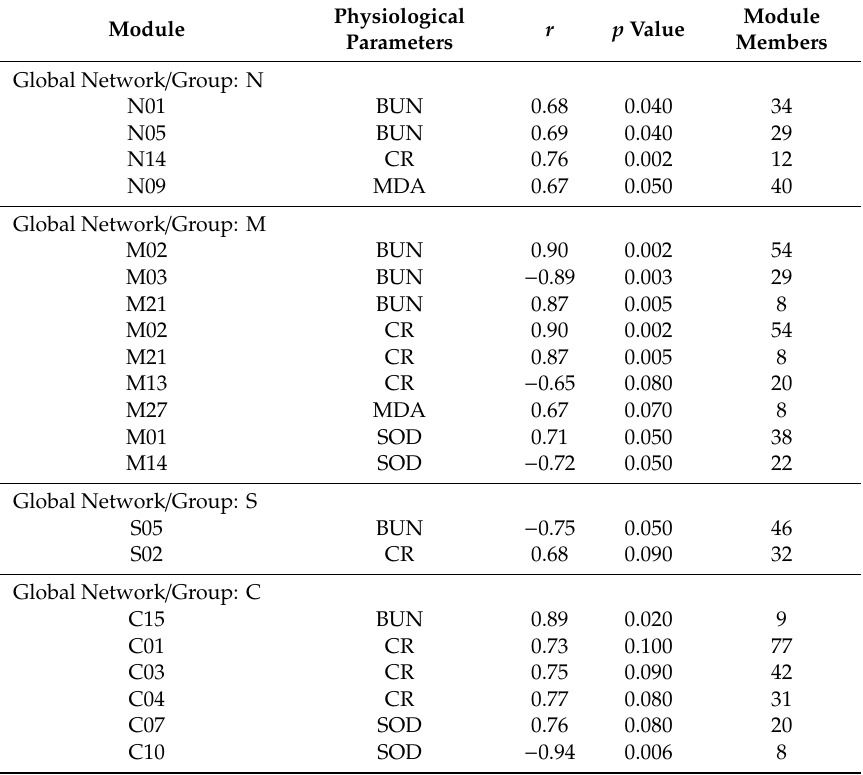
Table 1. The correlations between the eigengene values of select modules and physiological traits. N: healthy mice supplemented with PBS; C: healthy mice supplemented with a daily dose of 150 mg / kg bodyweight of chondroitin sulfate disaccharide (CSD) for 16 consecutive days; M: mice subjected to exhaustive exercise stress supplemented with PBS; S: the stressed mice supplemented with a daily dose of 150 mg / kg bodyweight of CSD for 16 days. BUN: Blood urea nitrogen; CR: creatinine ratio; MDA: malondialdehydes; SOD: superoxide dismutase.